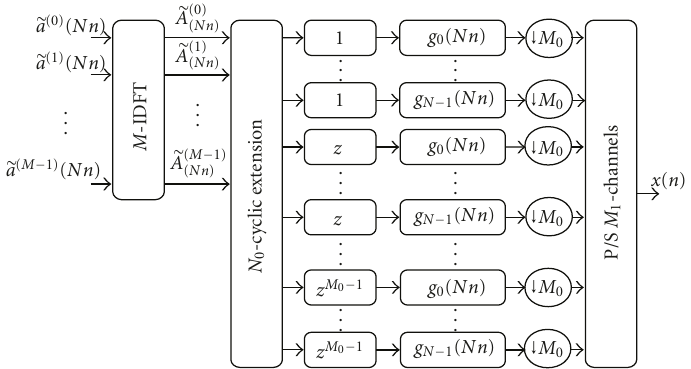
Figure 2: Synthesis bank (method A).